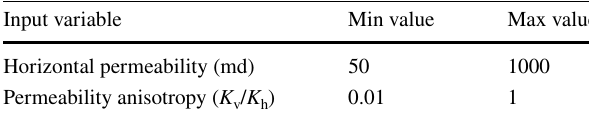
Table 2 Reservoir permeability